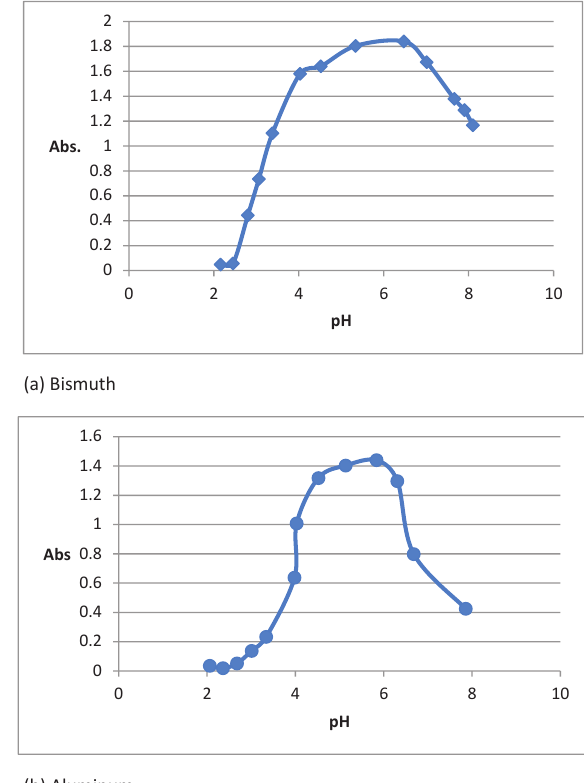
Figure 21: Effect of temperature on complex formation.